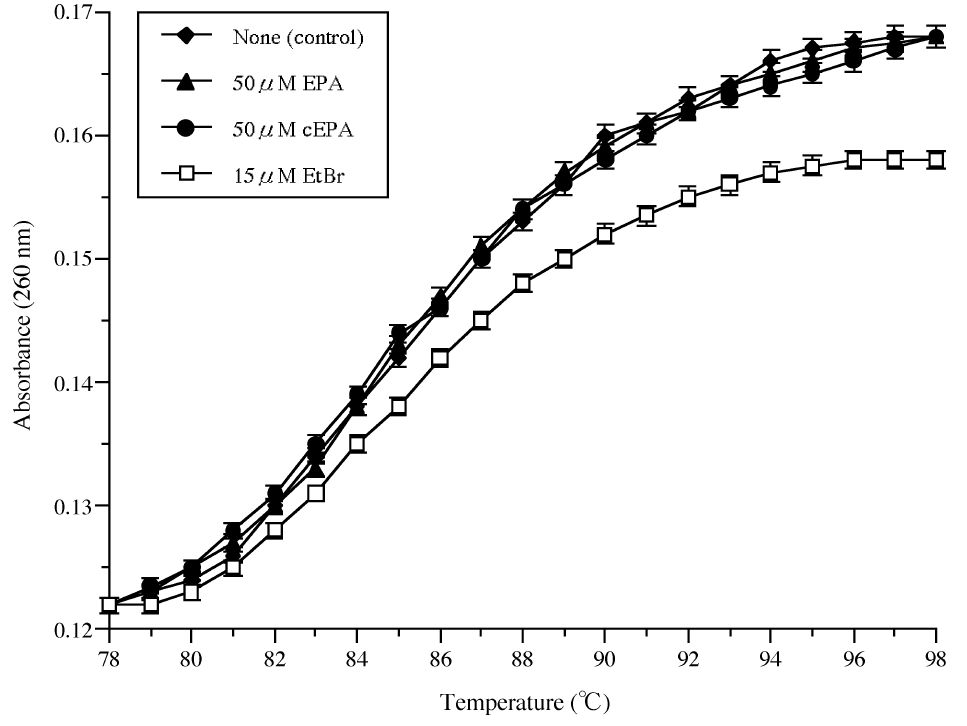
Figure 3. Effects of cEPA and EPA on the thermal transition of double-stranded DNA. Values are shown as the means ± SEM of three independent